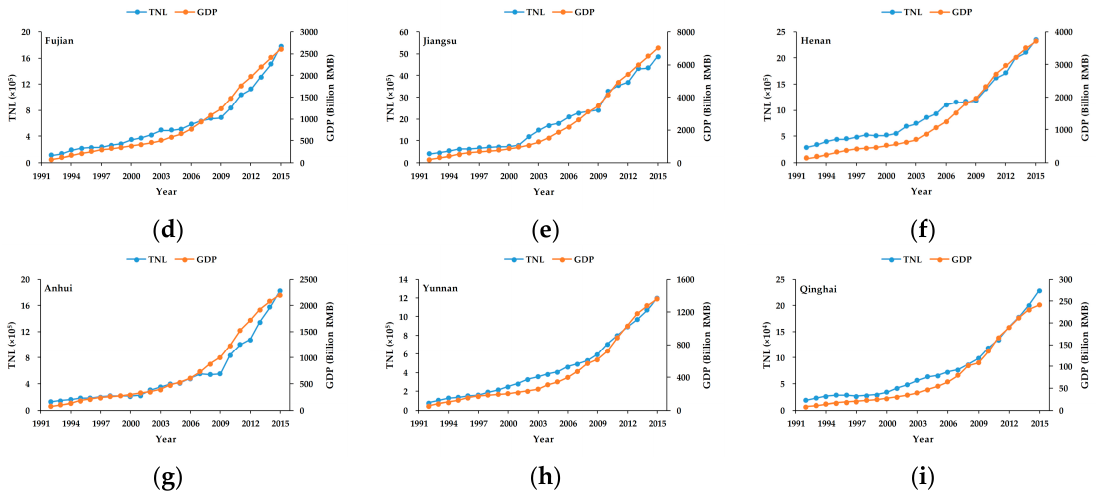
Figure 2. TNL from the extended temporal coverage data and GDP from 1992 to 2015: ( a ) China; ( b ) Liaoning; ( c ) Beijing; ( d ) Fujian; ( e ) Jiangsu; ( f ) Henan; ( g ) Anhui; ( h ) Yunnan; ( i ) Qinghai.